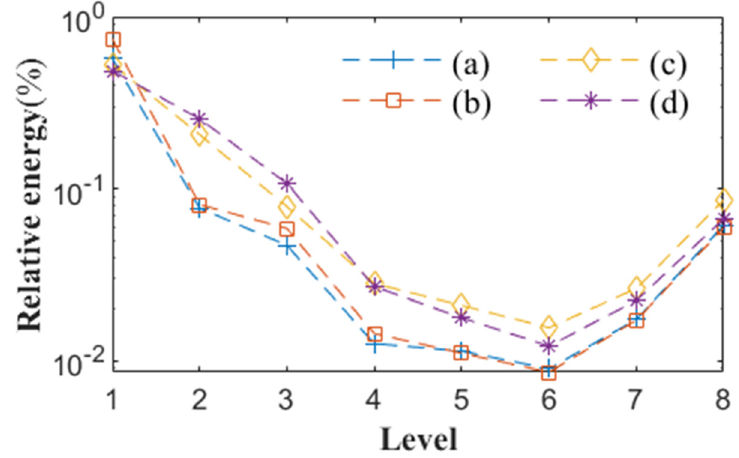
Figure 13. Relative energy ratio of eight wavelet levels in ( x , y )- and ( x , z )-plane. (a) Smooth cylinder in the ( x , y )-plane ( 𝑟 (cid:2869)(cid:3046) ), (b) 32-groove cylinder in the ( x , y )-plane ( 𝑟 (cid:2869)(cid:3034) ), (c) smooth cylinder in the ( x , z )-plane ( 𝑟 (cid:2870)(cid:3020) ), (d) 32-groove cylinder in the ( x , z )-plane ( 𝑟 (cid:2870)(cid:3034) ).